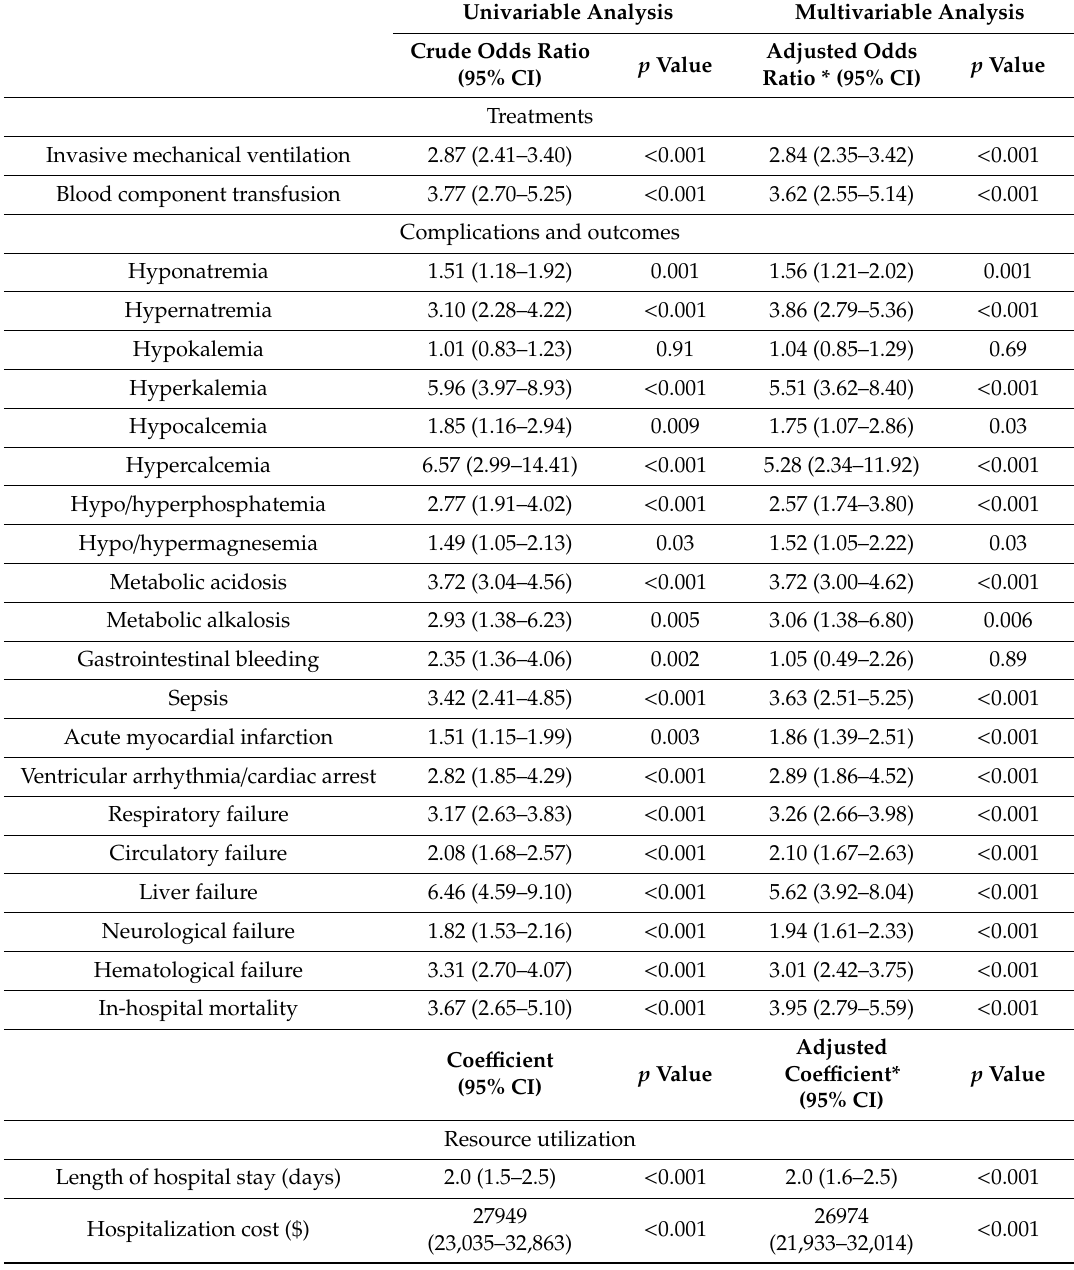
Table 3. The association between acute kidney injury and in-hospital treatment, complications, outcomes, and resource utilization in heat stroke